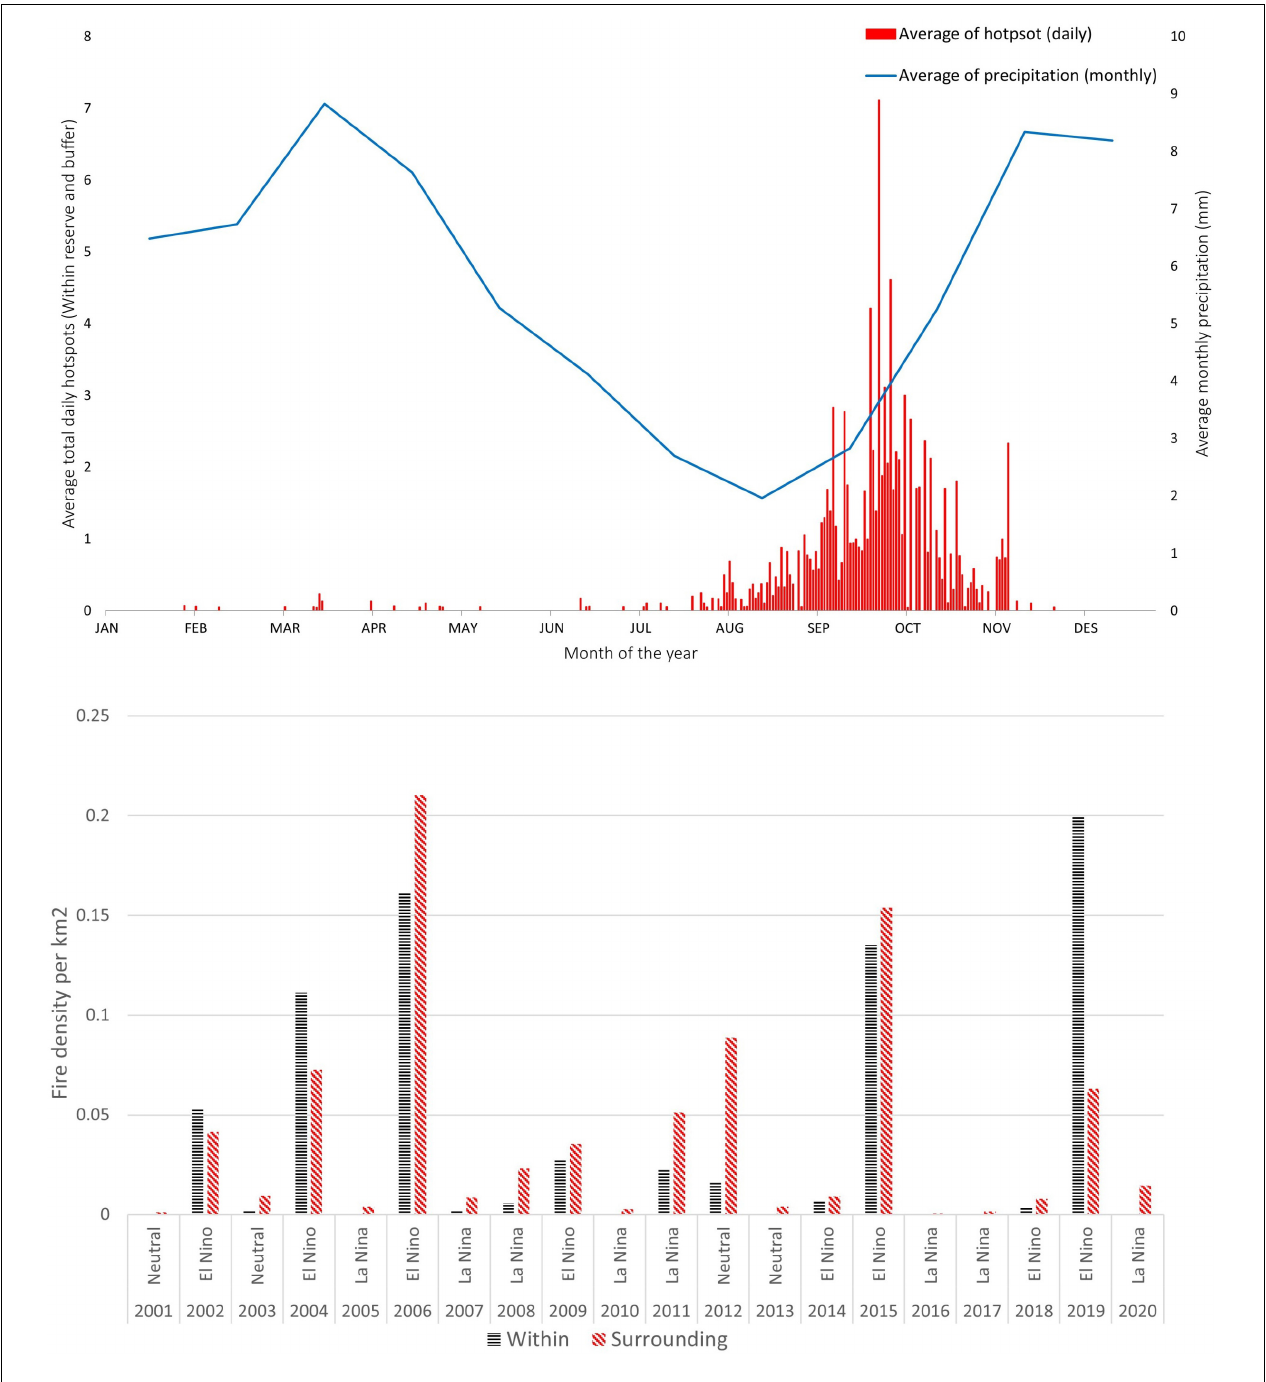
FIGURE 3 | The temporal relationship between the average total daily hotspots (within reserve and buffer) and the monthly average precipitation during 2001–2020 (above); and fire densities within and surrounding the PSWR during 2001–2020, with years classified based on El Niño Southern Oscillation (ENSO) state